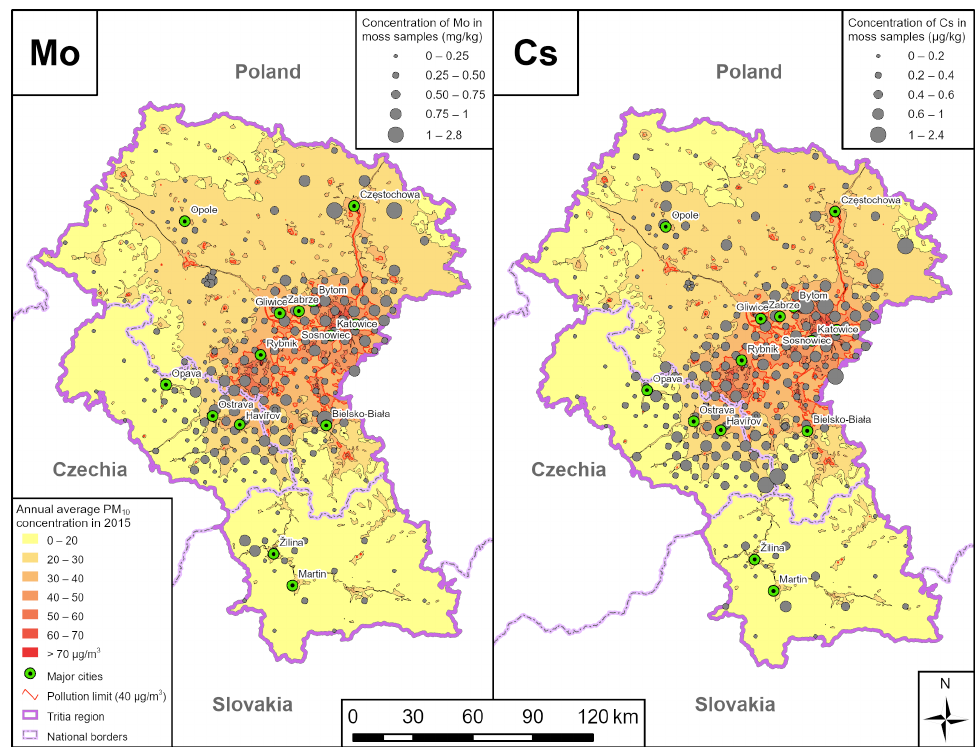
Figure 9. Mo and Cs concentrations determined by INAA in mosses and ADMOSS results